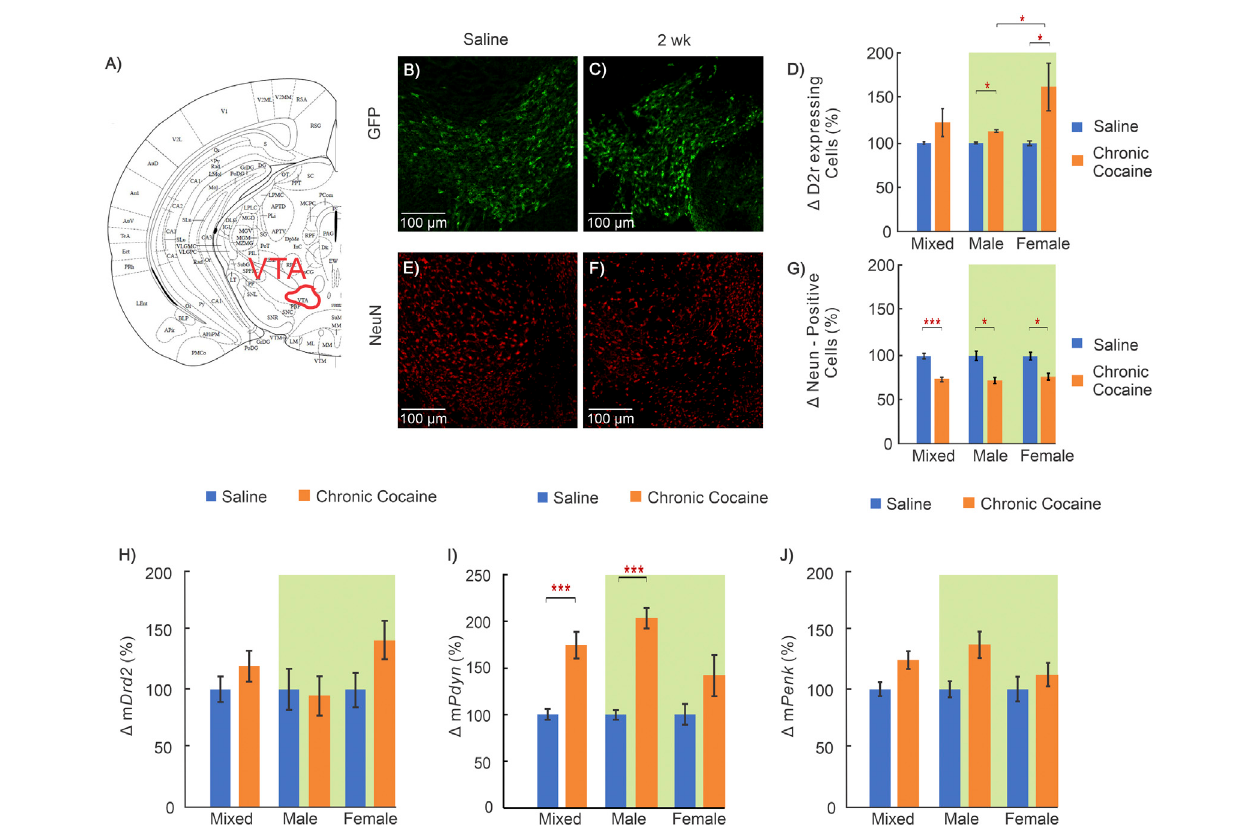
FIGURE6| Effectsofcocaineintheventraltegmentalarea(VTA) (A) :MousebrainatlasshowinglocationofVTAwhereimageswereobtained(GeorgeandFranklin, 2001); (B — C) : “ Zoom-in ” GFP representative images in a control and (E – F) for a cocaine exposed animal for D2r-GFP and NeuN respectively; (D) : Comparison of D2r- GFP expressing neurons between saline (blue, n (cid:2) 11; 5 \ , 6 _ ) and cocaine animals (orange, n (cid:2) 11; 6 \ , 5 _ ); (G) : Comparison of total neuronal population between saline(n (cid:2) 9;4 \ ,5 _ )andcocaine(n (cid:2) 10;5 \ ,5 _ )exposedanimals; (H – J) :ComparisonofmRNAlevelsbetweencontrol(n (cid:2) 12;6 \ ,6 _ )andcocaine(n (cid:2) 14;7 \ , 7 _ ) animals for Drd2 (H) , Pdyn (I) , and Penk (J) . Mixed: males and females; female: females only; male: males only; Data compared with two-way ANOVA indicated by green background; *: p < 0.05; **: p < 0.005; ***: p <